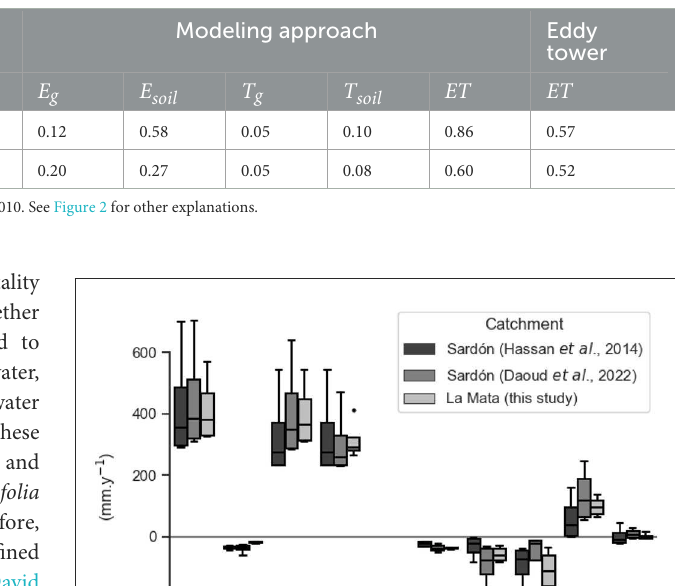
TABLE 4 Comparison between the results of: (a) the experimental approach of Balugani et al. (2017); (b) the modeling approach of this study; and (c) eddy tower measurements of evapotranspiration ( ET ). Year Experimental approach Modeling approach Eddy